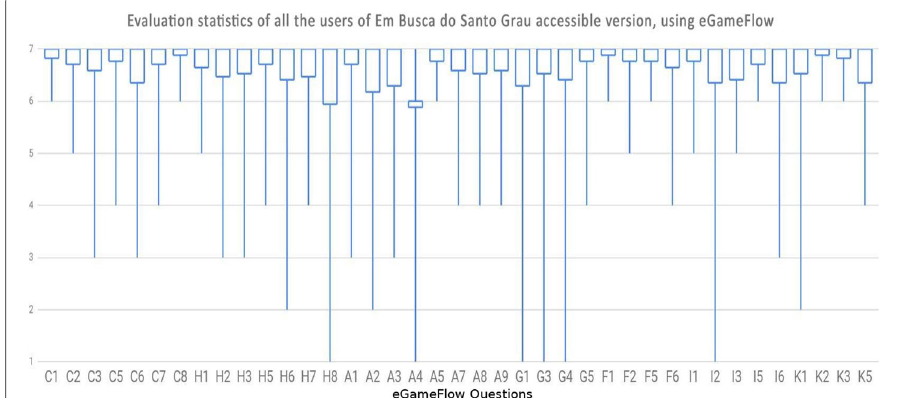
Fig. 8 Box plot chart - User evaluation result using eGameFlow